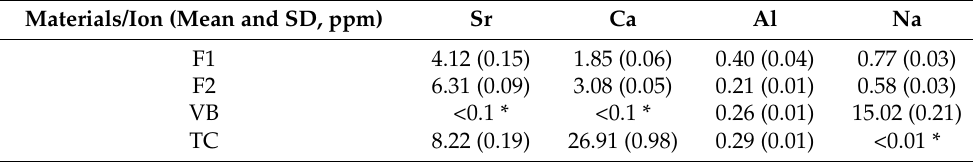
Figure 9. ( A ) Cumulative fluoride release versus immersion time (square root of time); and ( B ) cumulative fluoride release at 8 weeks from F1, F2, and VB. Error bars are SD ( n = 3). The lines indicate p < 0.05. Table 2. Cumulative aluminum, calcium, strontium, and sodium ion release at 8